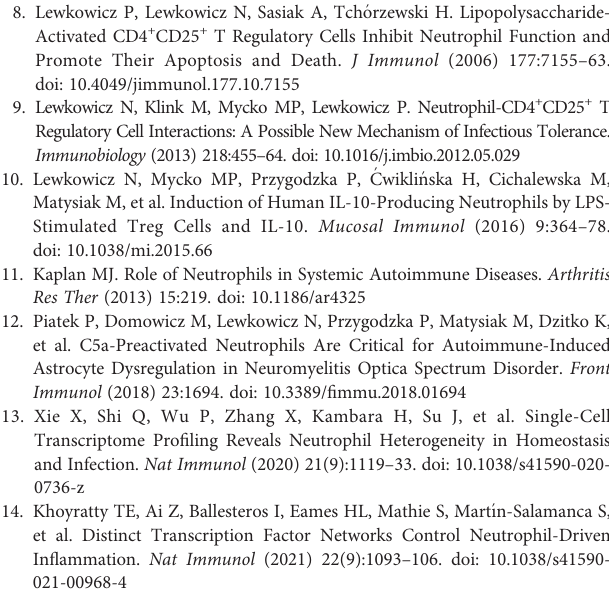
Supplementary Table 1 | (A) The pro fi le of cytokines/chemokines/growth factors released by non-, LPS, TNF- a , or IL-10-stimulated neutrophils. Data are presented as means ± SD calculated from the four independent experiments. (B) Thepro fi leofcytokines/chemokines/growth factorsreleasedbyneutrophilsisolated from whole blood healthy volunteers, sepsis, NMOSD, and periodontitis patients. Data are presented as means ± SD. Supplementary Table 2 | The list of all identi fi ed peaks within H3K4me3 in non-, LPS, TNF- a , or IL-10-stimulated neutrophils; neutrophils isolated from healthy volunteers, sepsis, NMOSD, and periodontitis patients. All peaks were divided into logical subsets speci fi c for non-, LPS, TNF- a , or IL-10-stimulated ( in vitro model) or HC, sepsis, NMOSD, and periodontitis patients. Supplementary Table 3 | The list of all Gene Ontology (GO) processes that characterize non-, LPS, TNF- a , and IL-10-stimulated neutrophils; neutrophils isolated from patients with sepsis, NMOSD, periodontitis, and HC. GO was performed by analyses of biological processes, molecular function, cellular components as well as pathway interactions. Data are arranged from the highest statistically signi fi cant value to the lowest one. Supplementary Table 4 | (A, B) . The list of target genes in the GO terms: ‘ mTOR signaling pathway ’ , ‘ neutrophil activation ’ , ‘ cytokines, ’ and ‘ apoptotic process ’ divided into logical subsets speci fi c for non-, LPS, TNF- a , or IL-10-stimulated neutrophils. Supplementary Table 5 | The list of all tested mRNA for genes associated with activation of neutrophils via NF- k B. Data are presented as the relative fold differencesto n.s. neutrophils. ‘ H3K4me3TSS regions ’ column presentsgenesthat are positioned by H3K4me3. Total count readings ≥ 10, within the fi rst intron, were set as the detection